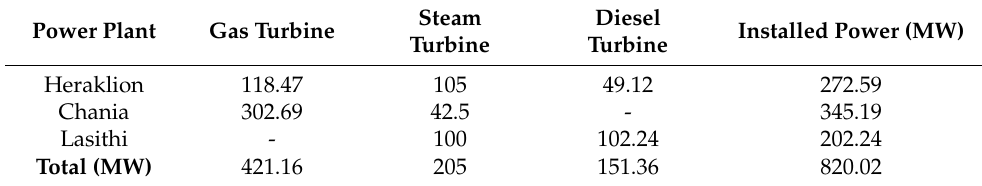
Table 3. Generation capacity of Crete.